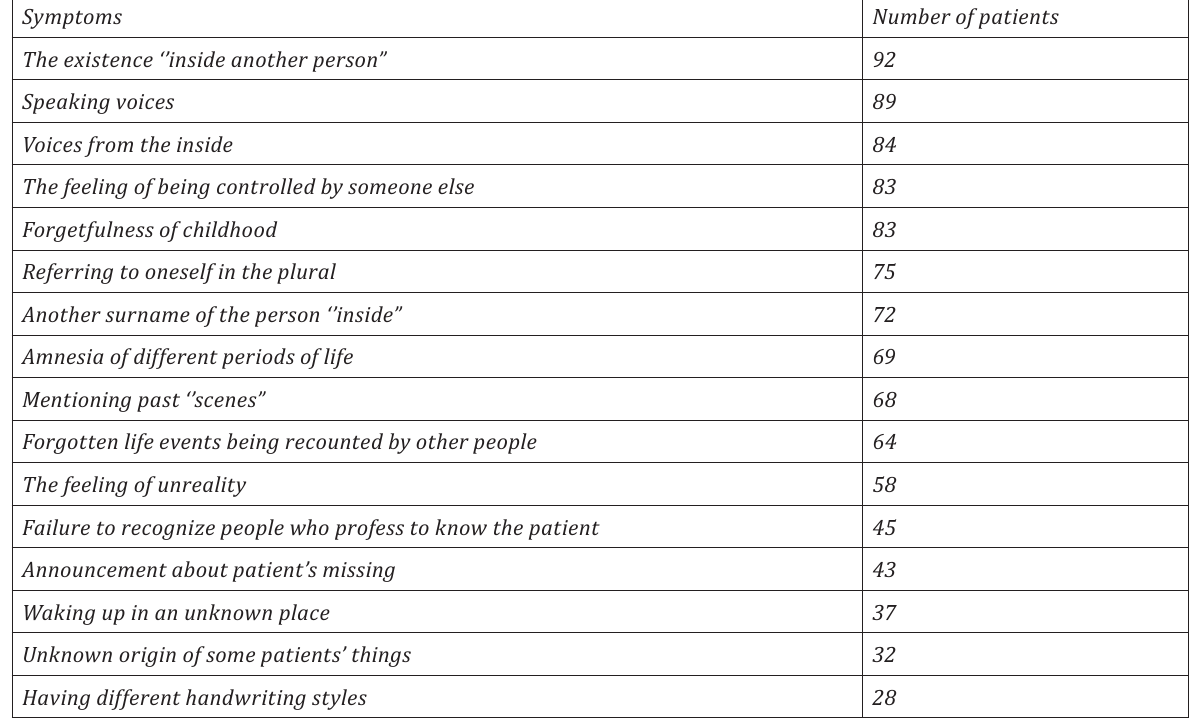
Table 1. The most common psychopathologic symptoms of